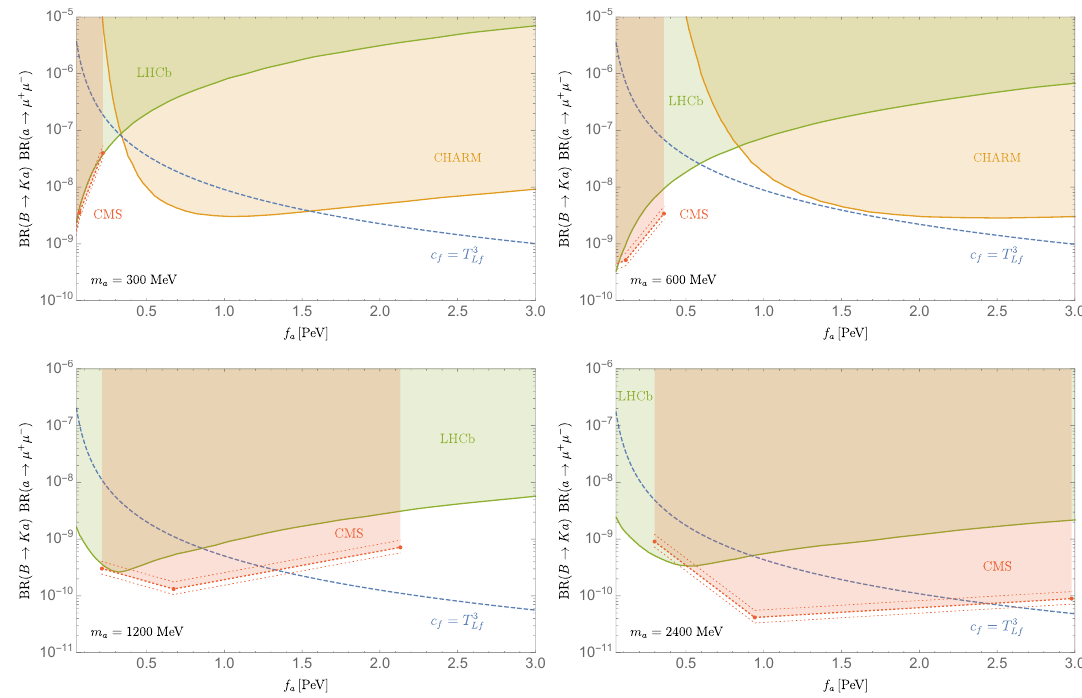
Figure 6 . B → K ( a → µ + µ − ) branching ratio of an ALP coupled to weak isospin (dashed blue curve), compared to regions excluded by LHCb ([66], green), CHARM ([66], orange), and CMS ([68], red), for four representative values of m . For CMS we display the uncertainty stemming from the a relation between inclusive and exclusive branching